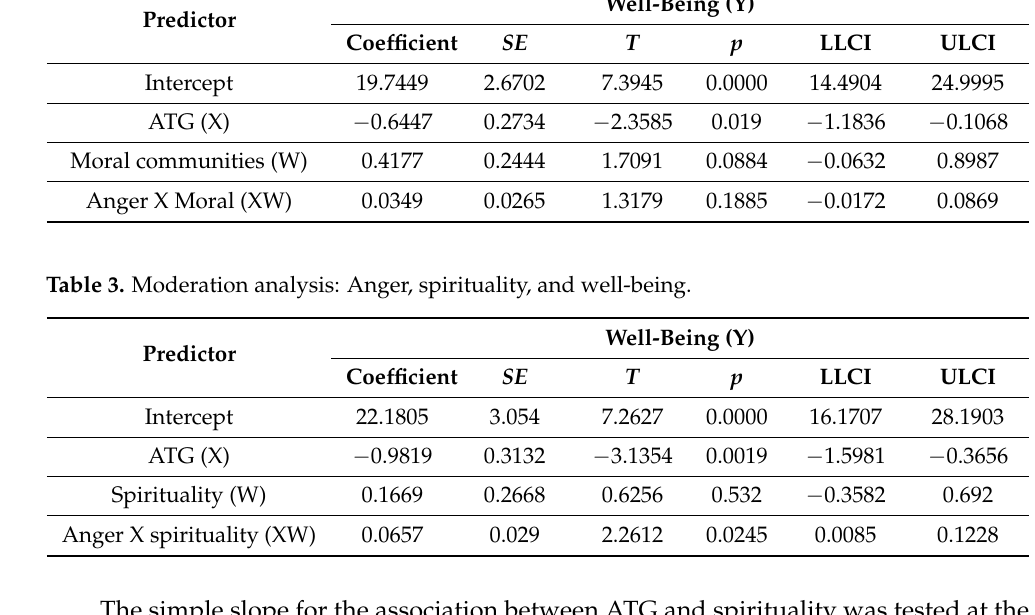
Table 2. Moderation analysis: Anger, moral community, and well-being. Predictor